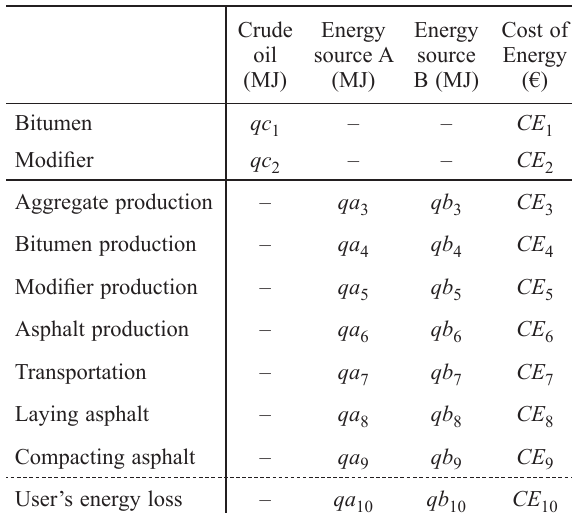
Table 1. Energy related